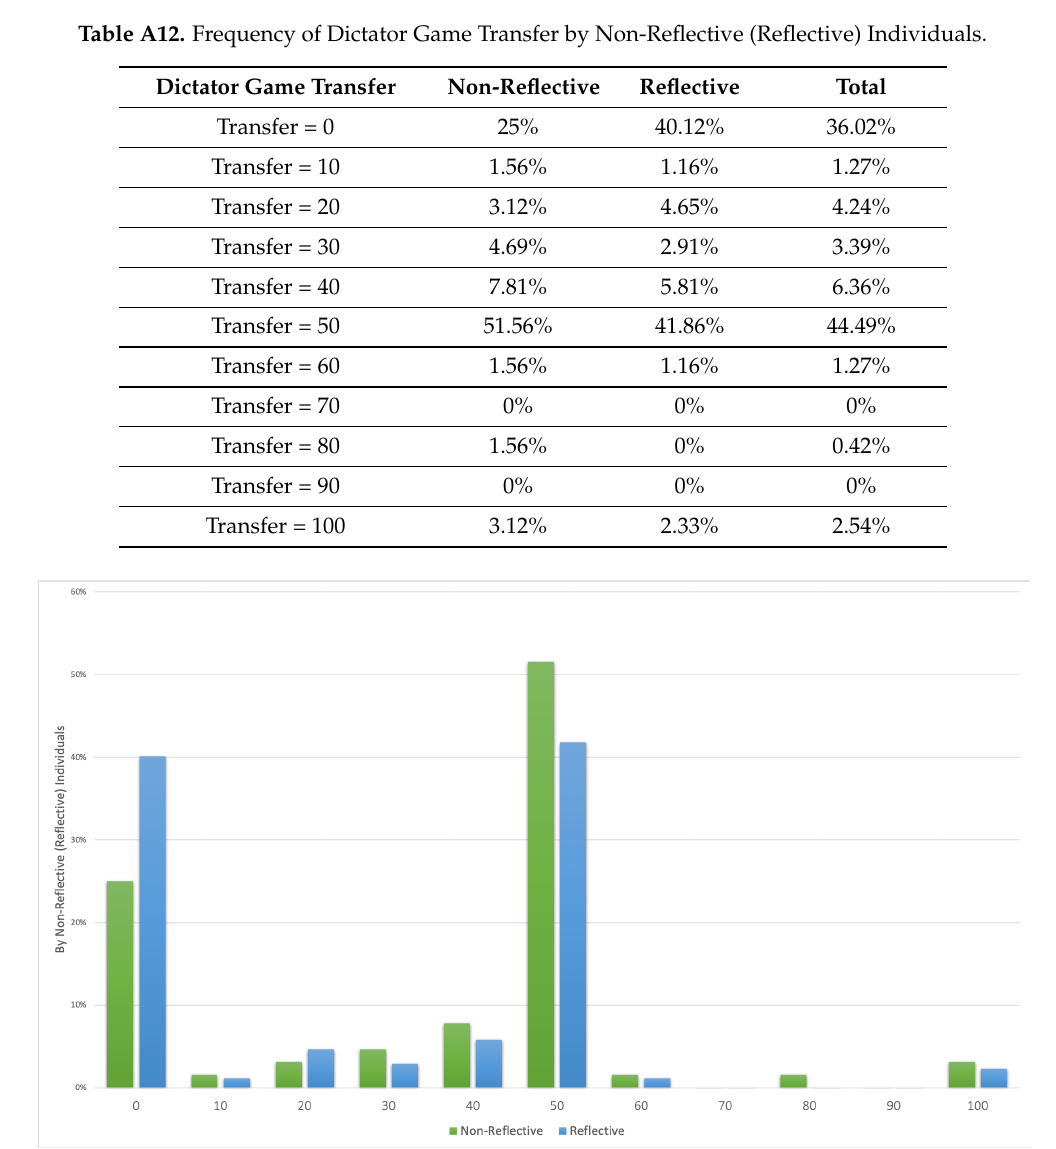
Figure A6. Frequency of Transfer by Non-Reflective (Reflective)